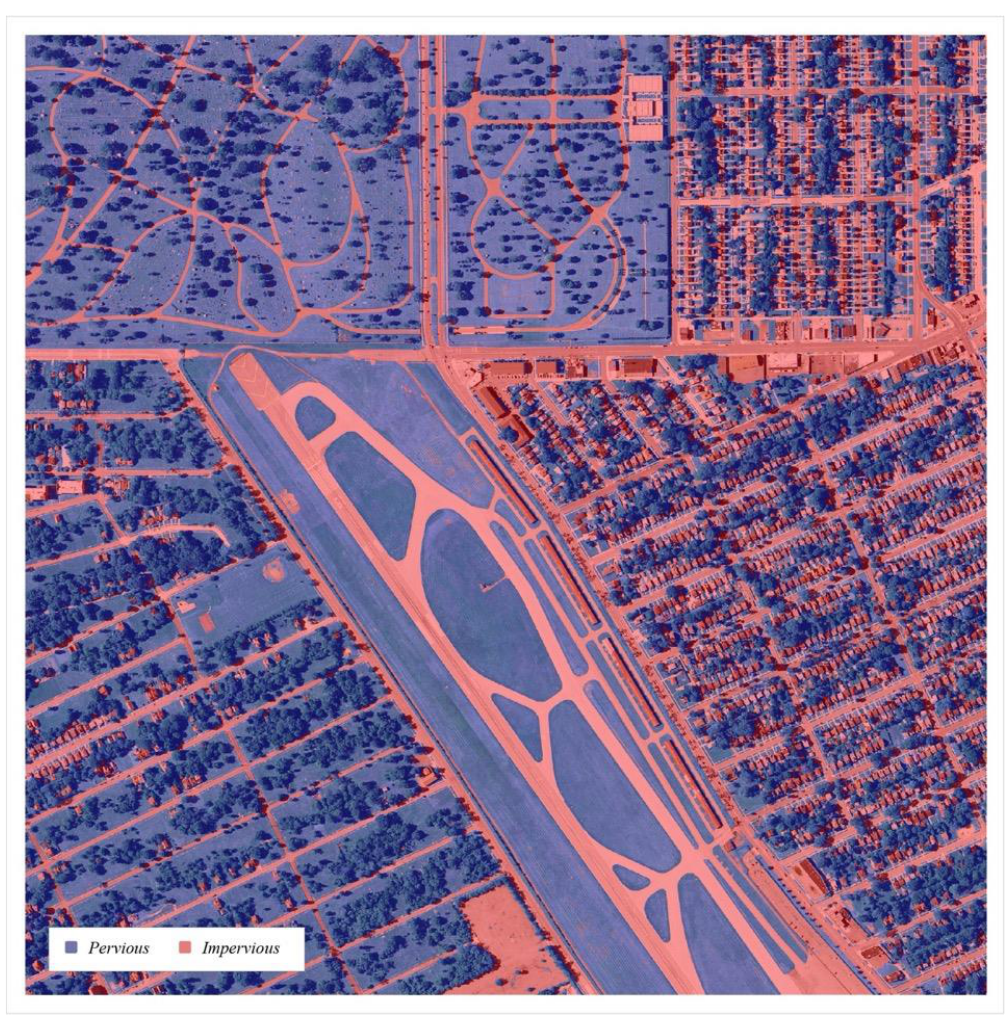
Figure 7. NAIP 2018 2.59 km 2 (one square mile) tile extent—classification result. Table 3. 2018 Accuracy statistics report of 300 sampling objects.